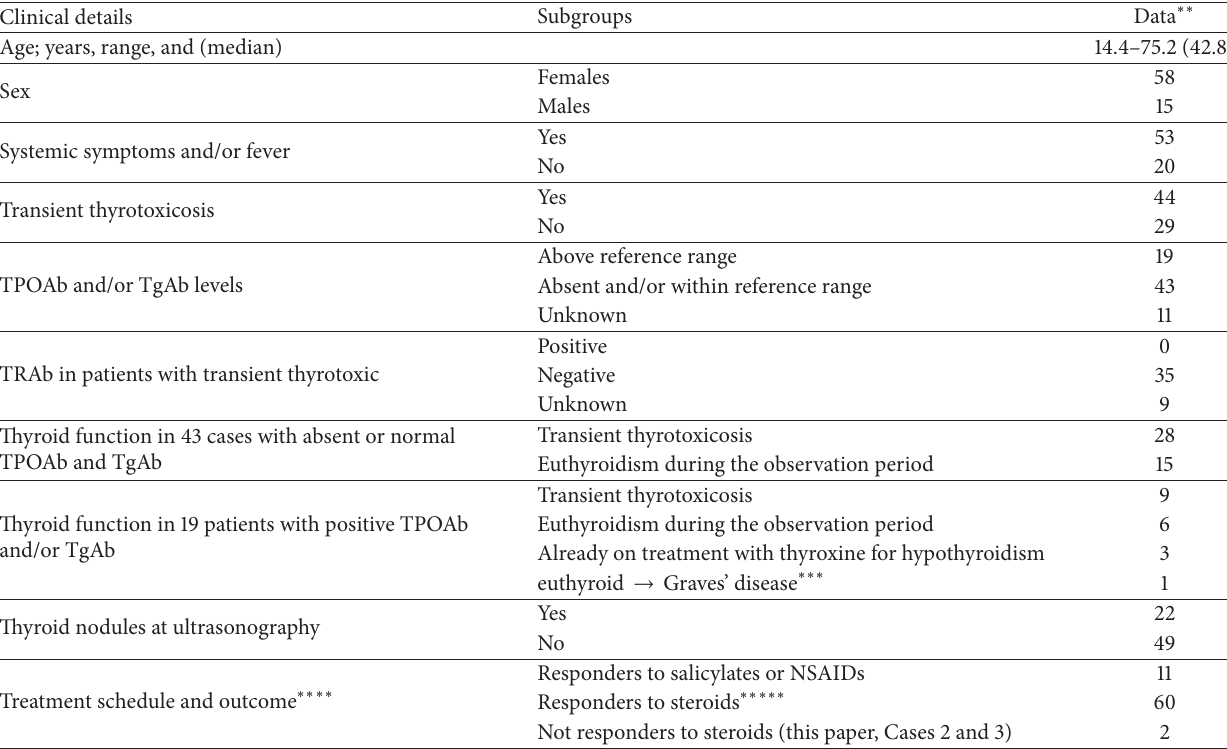
Table 1: Seventy-three patients with painful thyroiditis observed in the years 1996–2013; clinical and laboratory details ∗ .